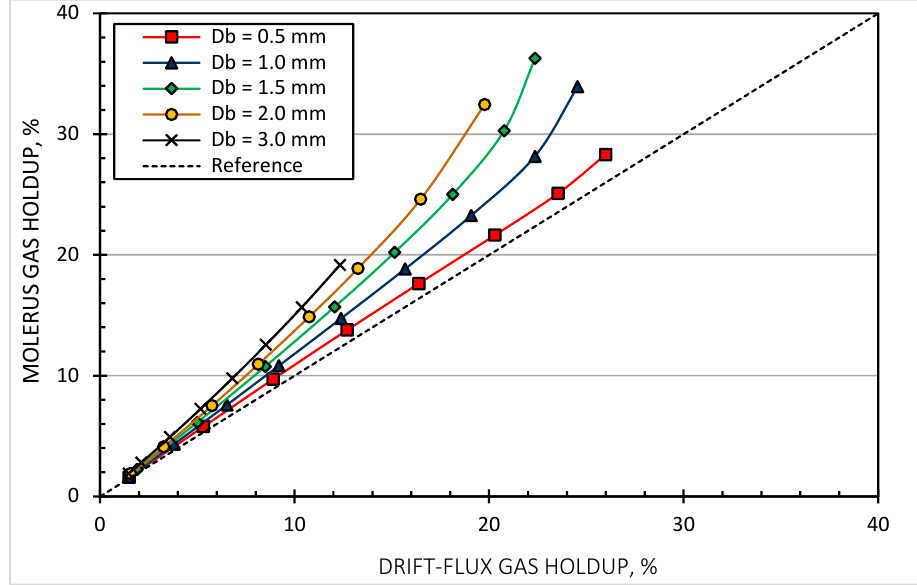
Figure 3. Comparison of gas holdup model predictions for selected bubble sizes and gas velocities.